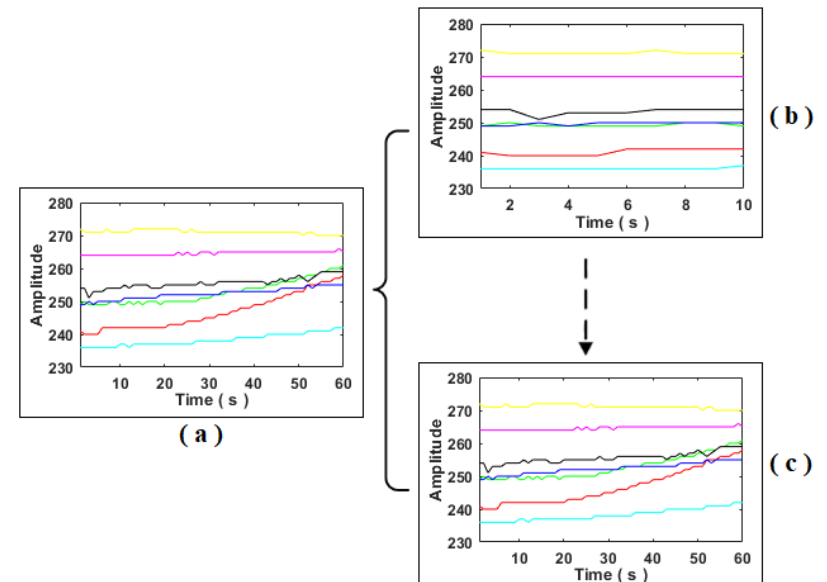
Figure 2. Sample slicing window protocol ( a ) whole data; ( b ) first window; and ( c ) sixth